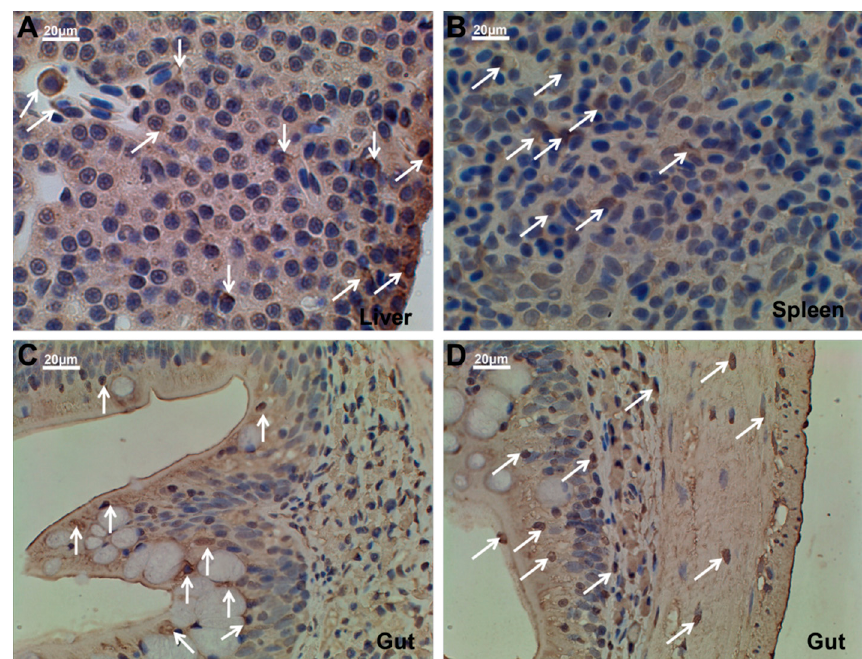
Figure 5. Expression of Ma -RNase1 in different tissues of M. amblycephala . Immunohistochemistry demonstrates Ma -RNase1 production (positive cells labeled in brown showing as white arrows) in the liver ( A ), spleen ( B ) and gut ( C , D ) tissues of two-year-old M. amblycephala . The negative cell nucleus labeled in blue and positive nucleus labeled in brown.